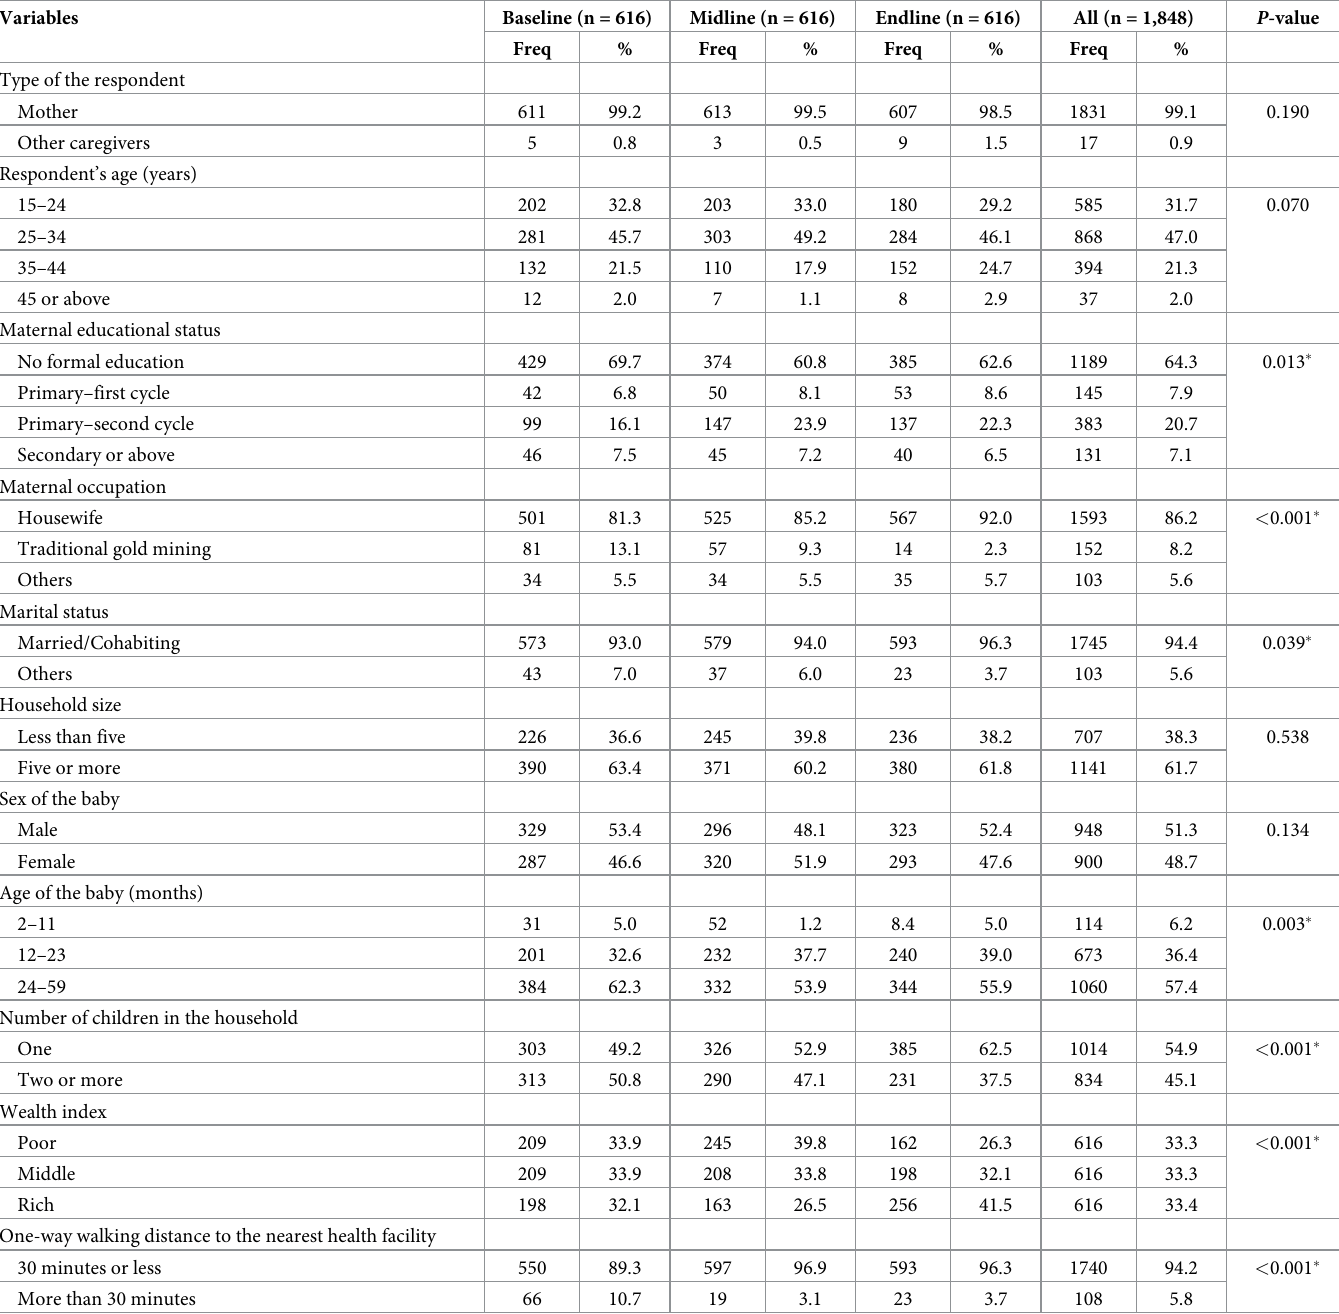
Table 1. Socio-demographic characteristics of the study participants of the baseline, midline and endline surveys, Assosa zone, Ethiopia, 2017–2018.